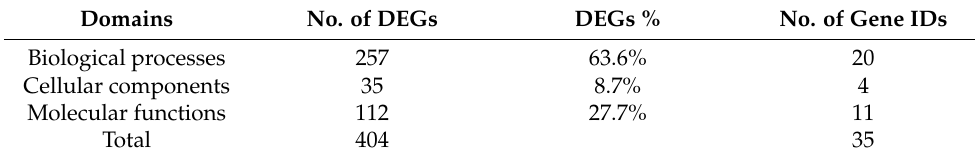
Table 6. Distribution of the enriched GO terms in three different domains in WH-1184. Domains No. of DEGs DEGs % No. of Gene IDs Biological processes 257 63.6% 20 Cellular components 35 8.7% Molecular functions 112 27.7% Total 404